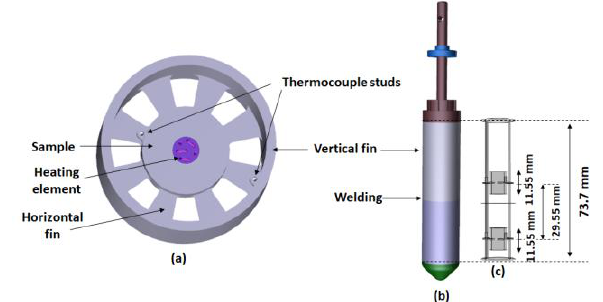
Fig. 4. Diagrams of the new CALORRE measurement calorimetric cell (a), the new assembly (b) and the geometry (c) considered for the 3-D numerical thermal simulations.